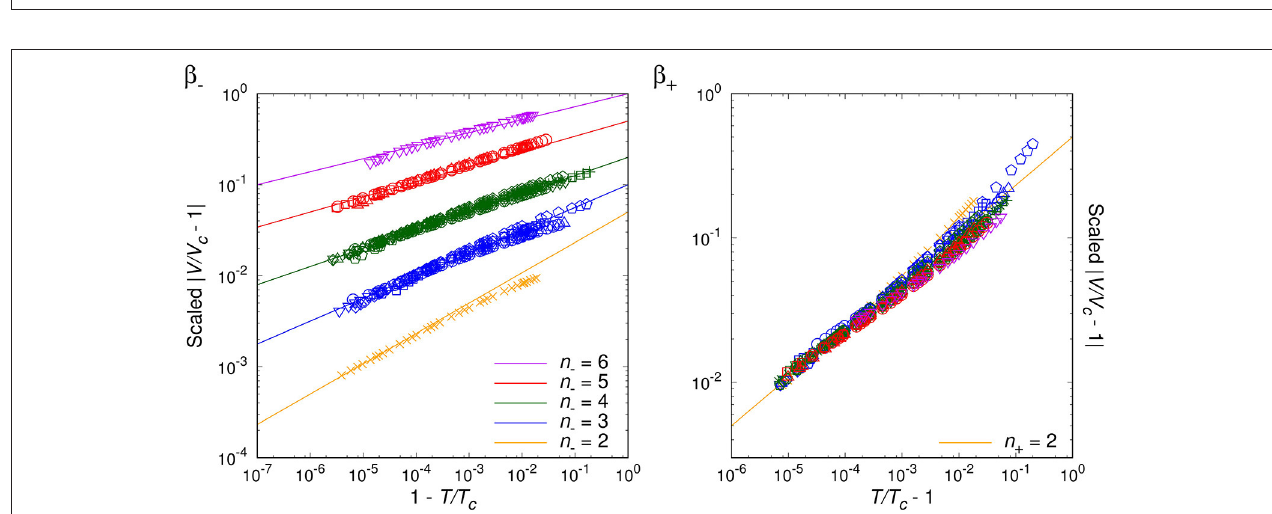
FIGURE 2 | Critical exponent, β P = 1 n + 1 : n − = 2,3,4,5,6 for T < T c and n + = 2 for T > T c .